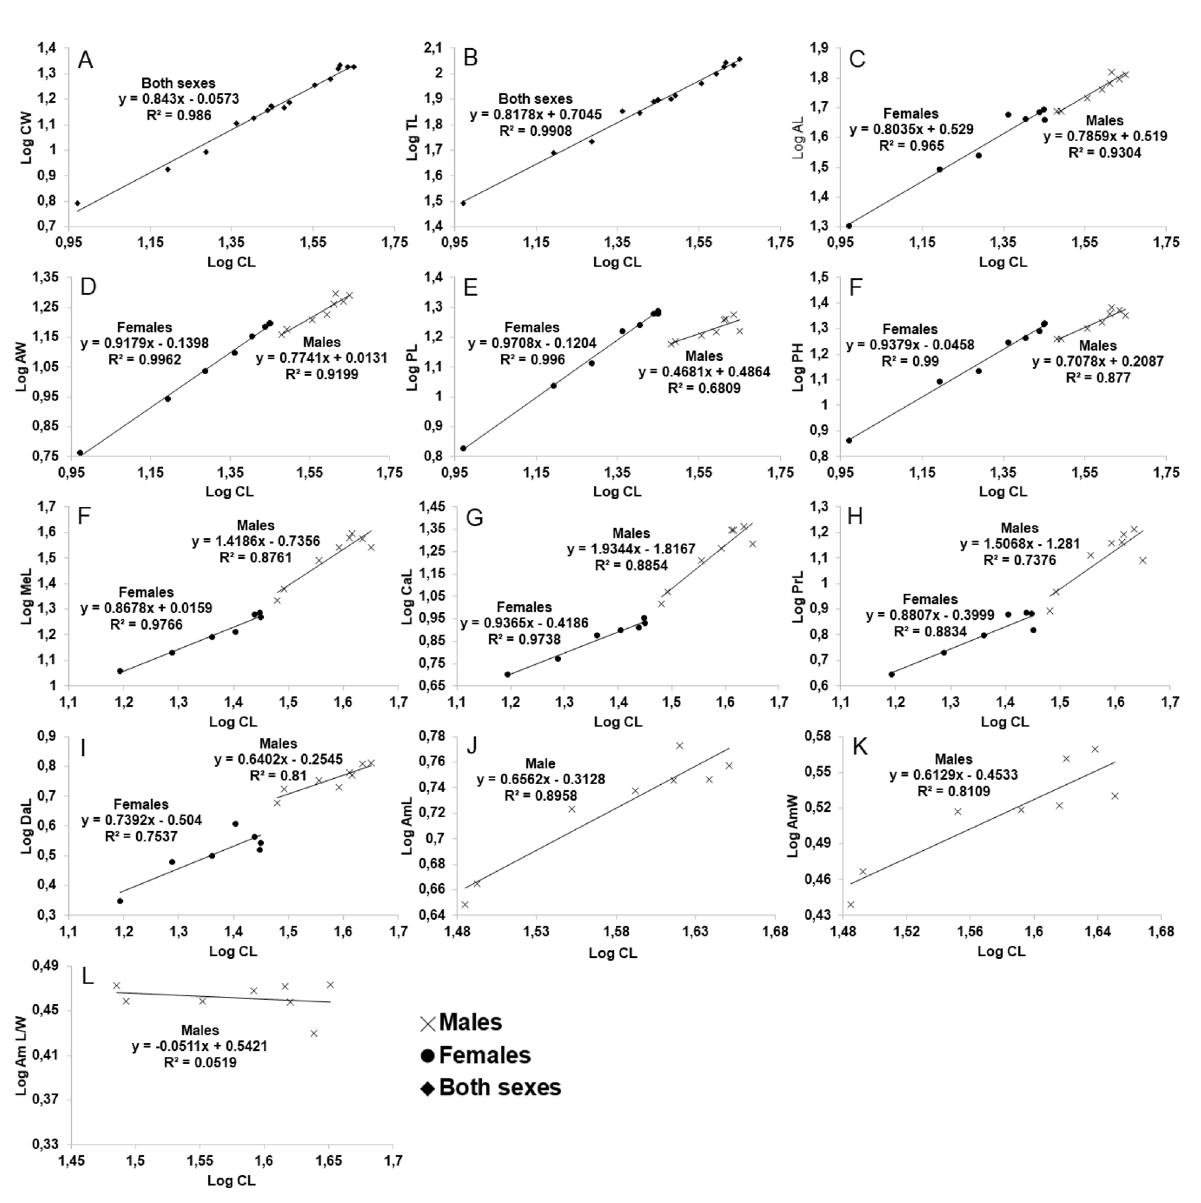
Figure 6. Comparison between morphometric relationships of males and females of Atya scabra (Leach, 1816) in the Fluvial Island Domain in the Paraíba do Sul River basin. (CL) carapace length as independent variable and the dependent variables: A , (CW) carapace width; B , (TL) total length; C , (AL) abdomen length; D , (AW) abdomen width; E , (PL) length of the second abdominal pleuron; F , (PH) height of the second abdominal pleuron; G , (MerL) merus length; H , (CarL) carpus length; I , (ProL) propodus length; J , (DacL) dactylus length; K , (AmL) length of male appendix interna; L , (AmW) width of male appendix interna; M , (Am L/W) male appendix interna